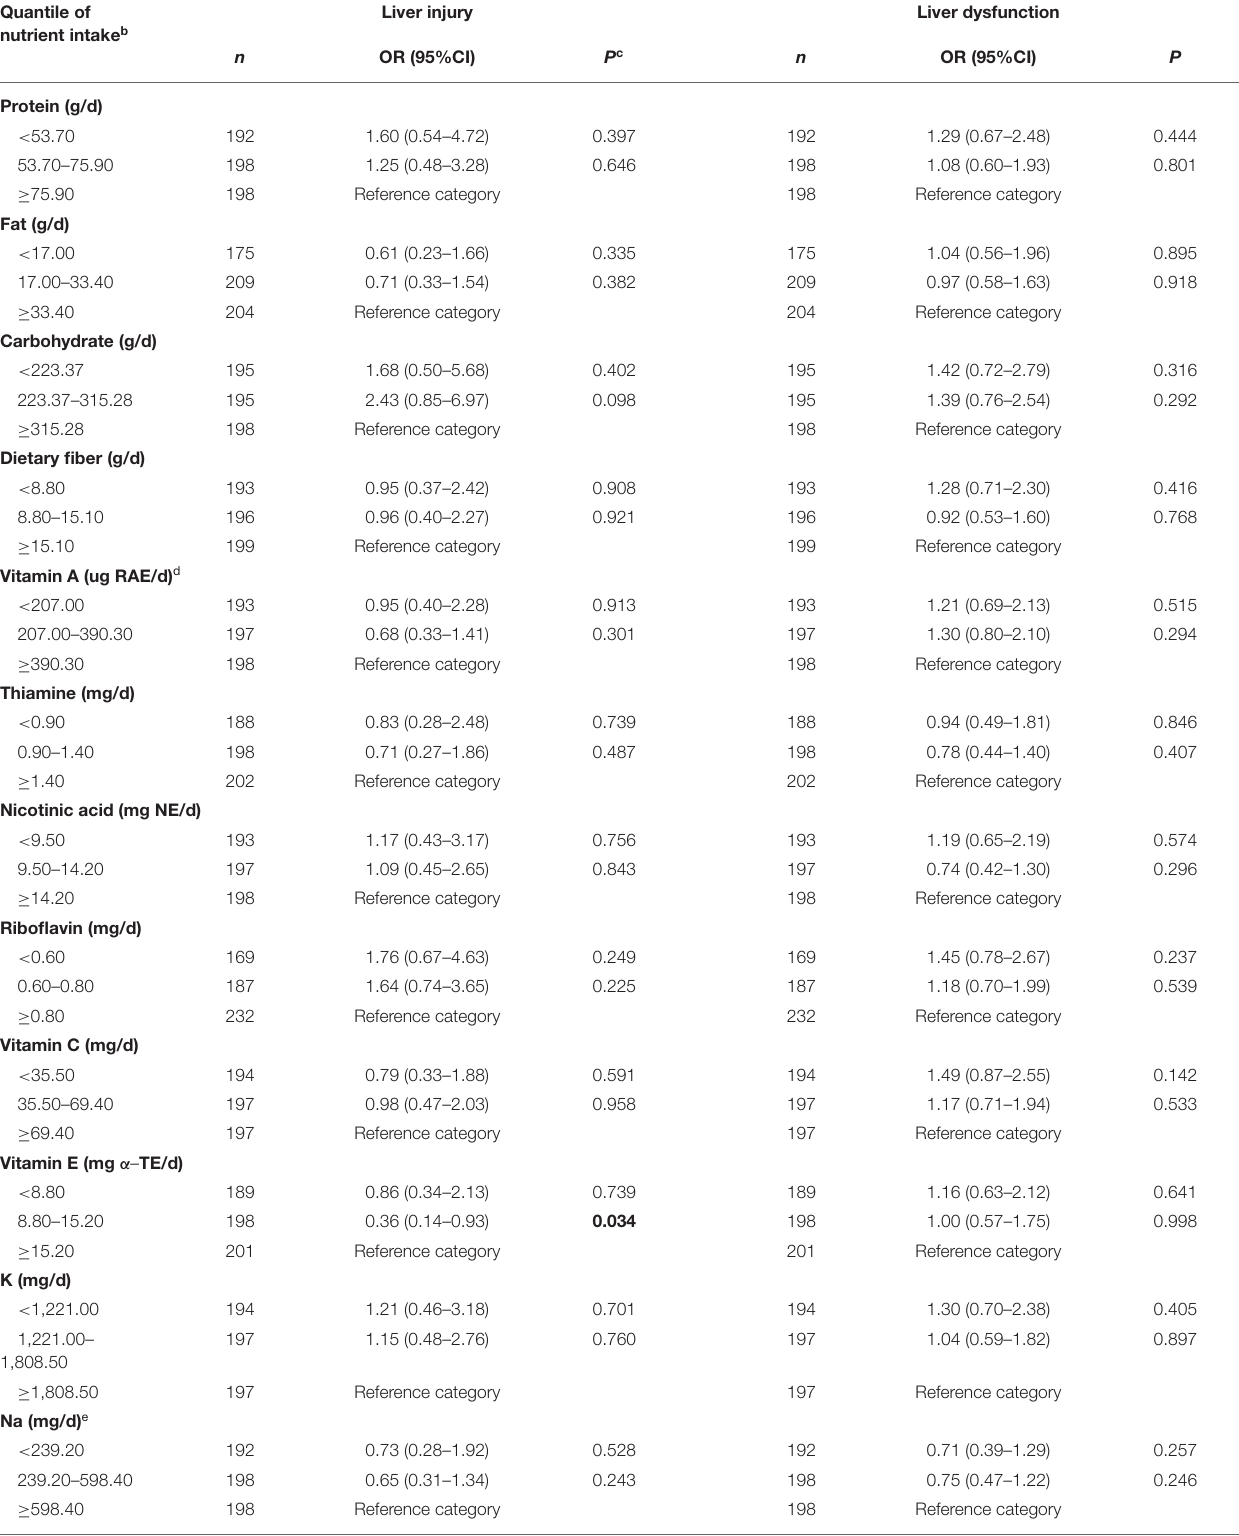
TABLE 4 | Nutrients intake in relation to the risk of liver injury and liver dysfunction during tuberculosis treatment a . Quantile of nutrient intake